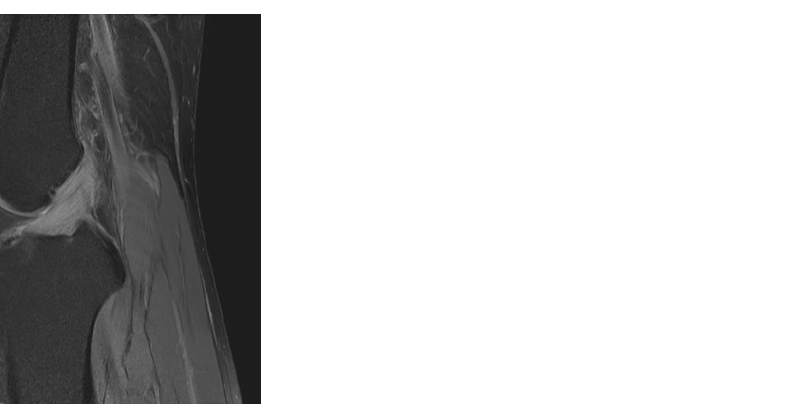
Figure 1. Preoperative proton density-weighted sagittal view of magnetic resonance imaging (MRI) shows overall high signal intensity and increased diameter of the anterior cruciate ligament (ACL) without discontinuity.